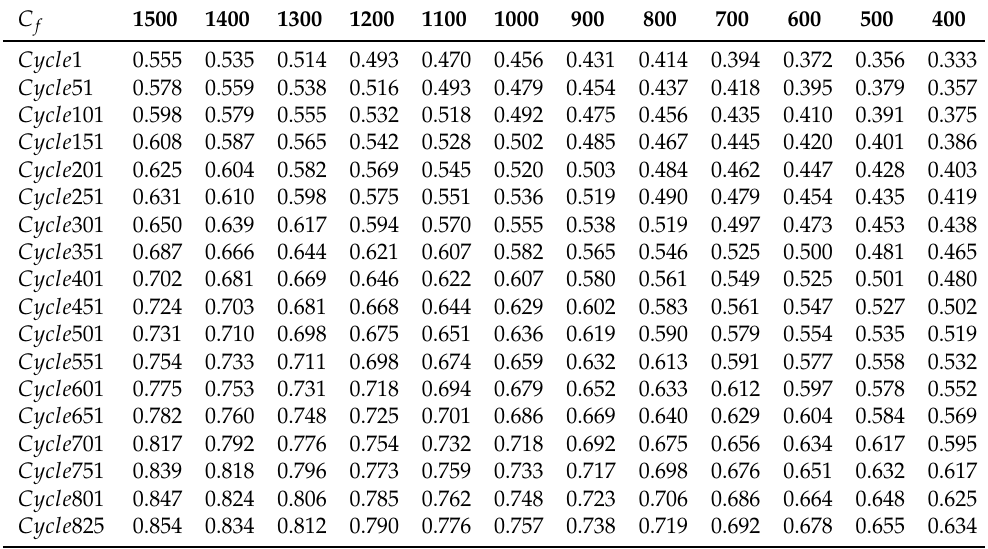
Table 4. Correspondence between the FDO and the cycle number (battery No. 001).